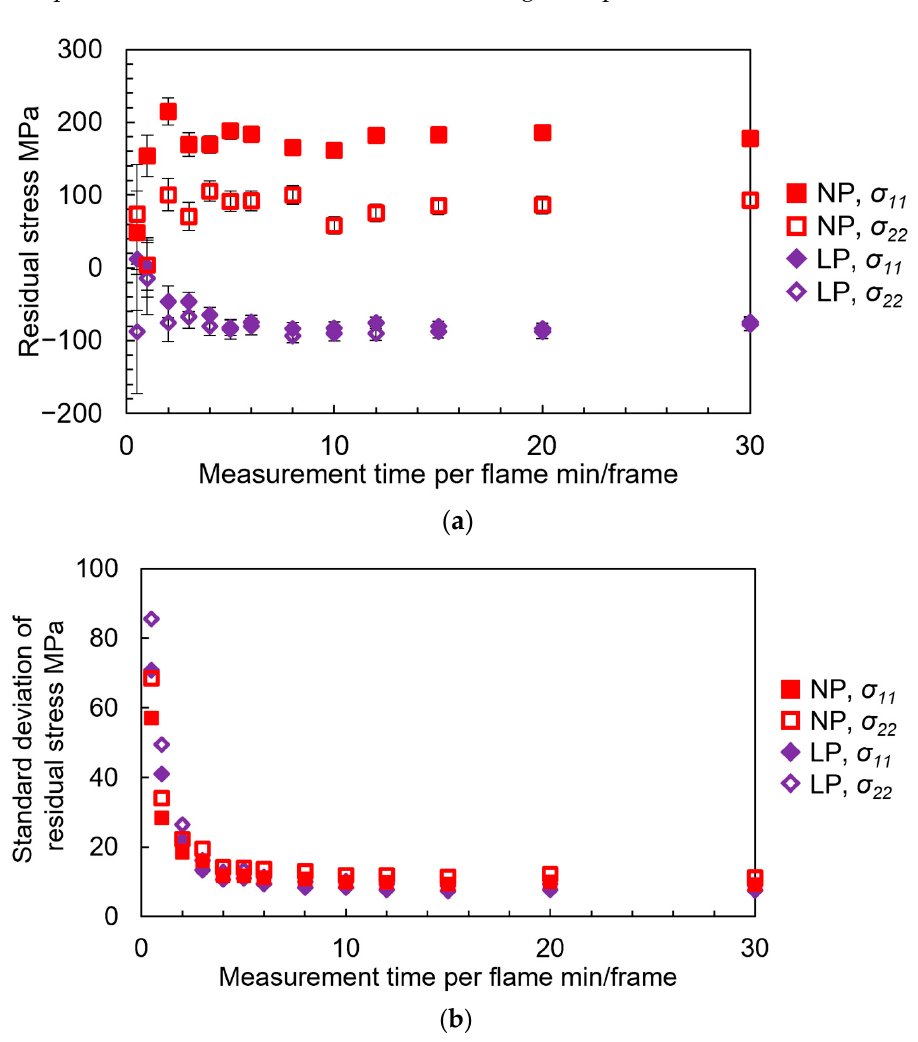
Figure 11. Residual stress of surface. ( a ) the average residual stress and standard deviation error bars; ( b ) only the standard deviation of ( a ).